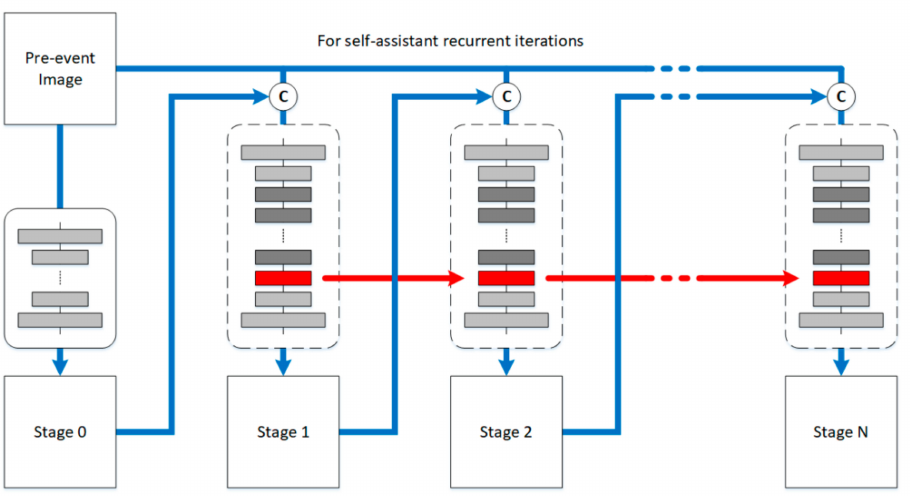
Figure 3. Overview of the progressive translation module. The dotted boxes indicate the ConvLSTM blocks that have shared the same weights and